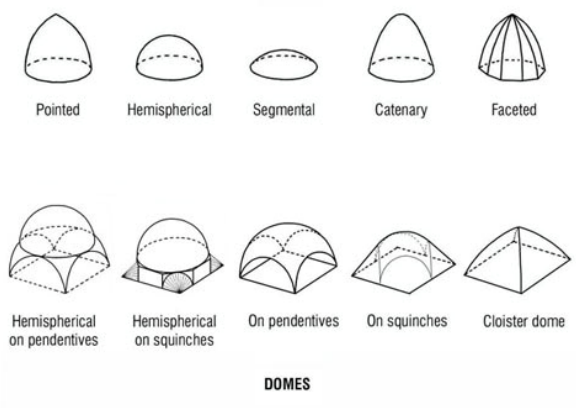
Figure 1. Geometric Domes classification, shape